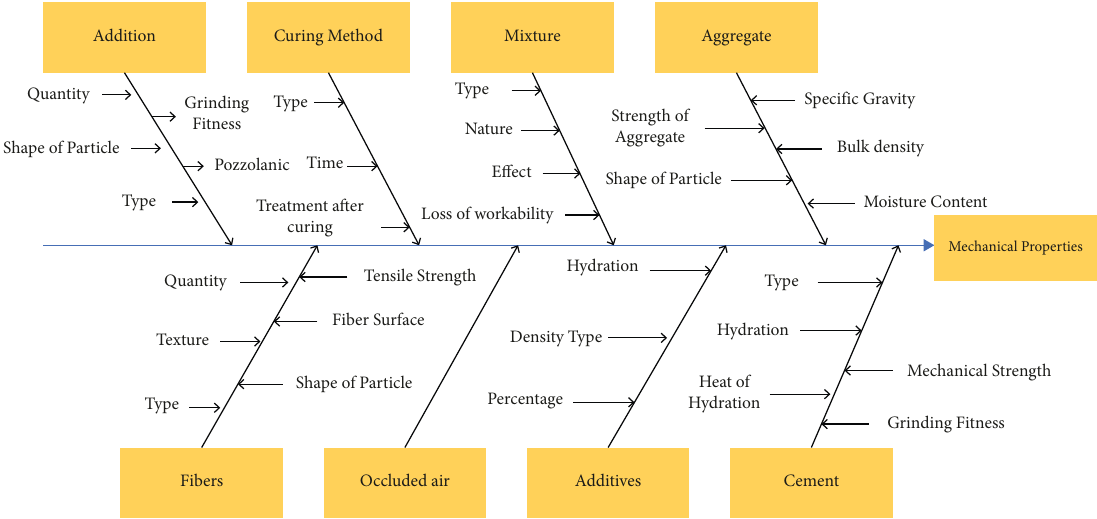
Figure 1: Factors affecting concrete properties. Table 2: Moisture strength.